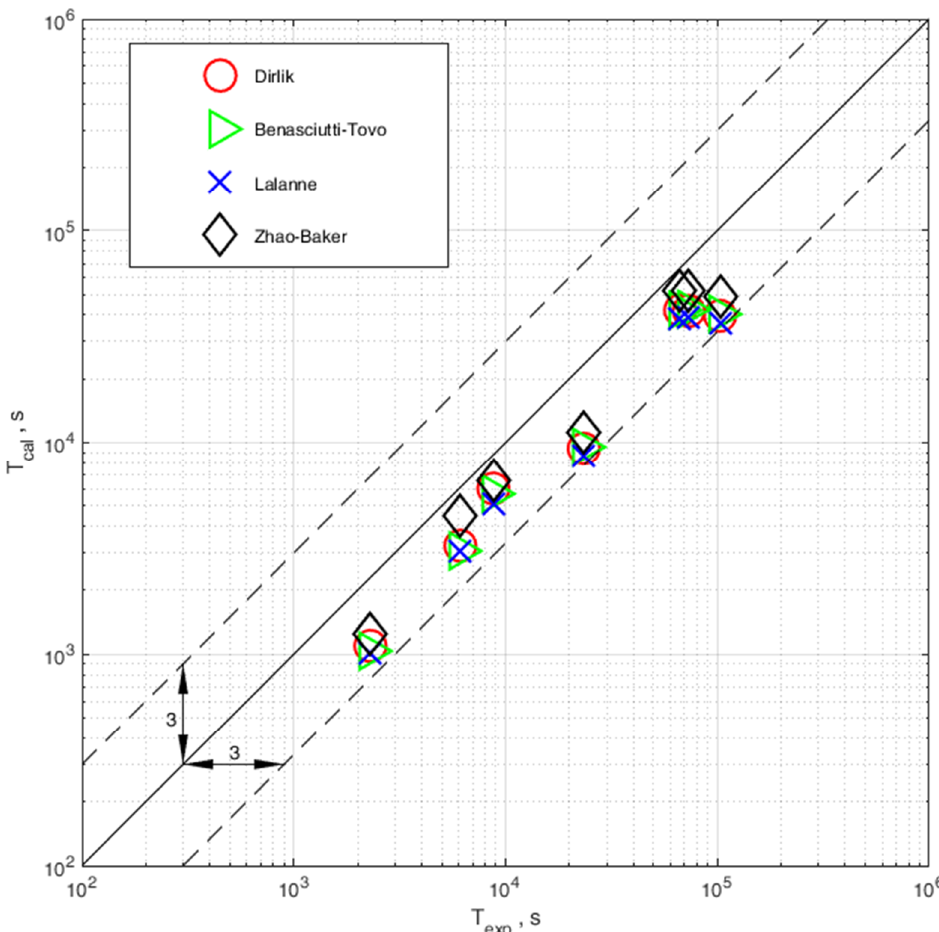
Figure 12. Comparison of experimental and computational durability calculated with the use of four probability density distributions (Dirlik, Benasciutti–Tovo, Lalanne and Zhao–Baker).